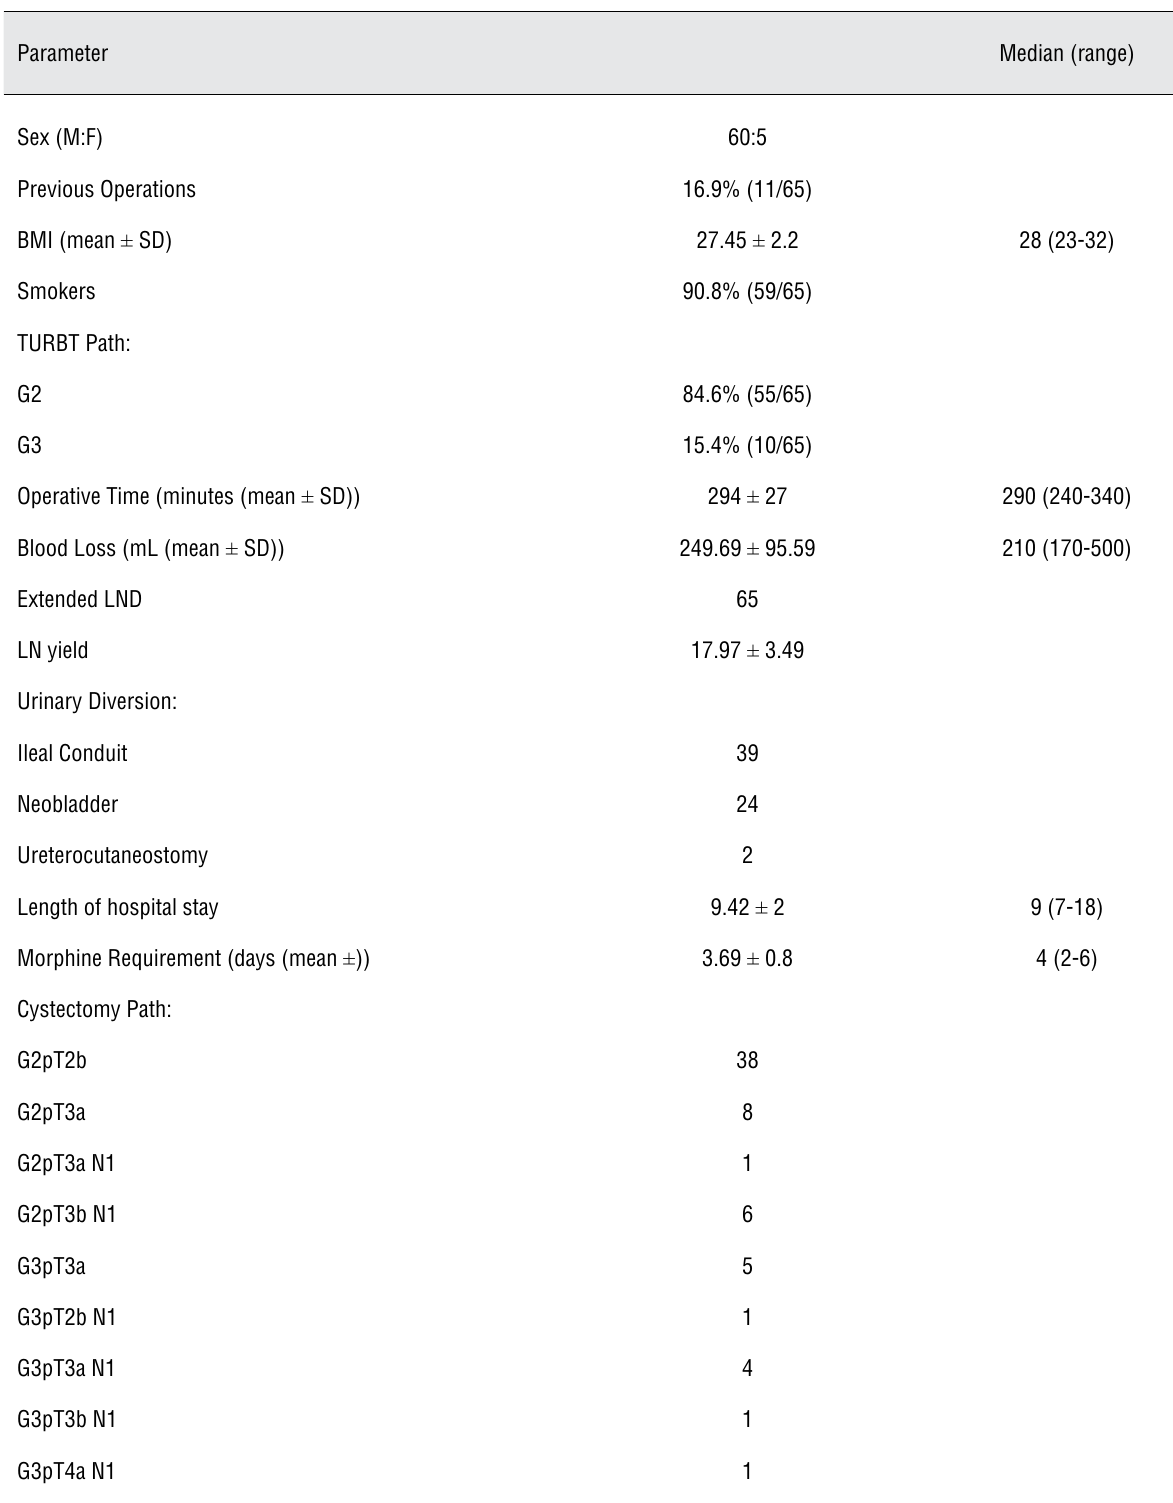
Table 1 - Patient Demographics and Operative